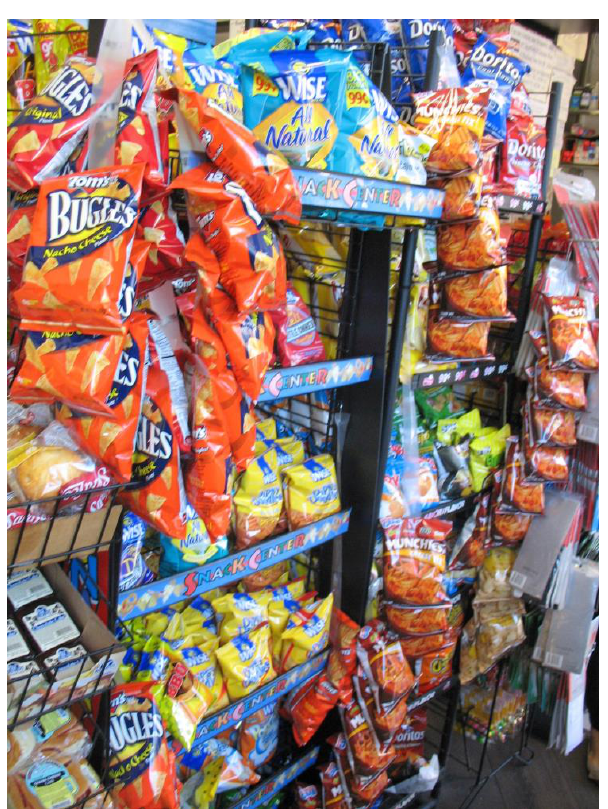
Figure 6. The wall of salt.